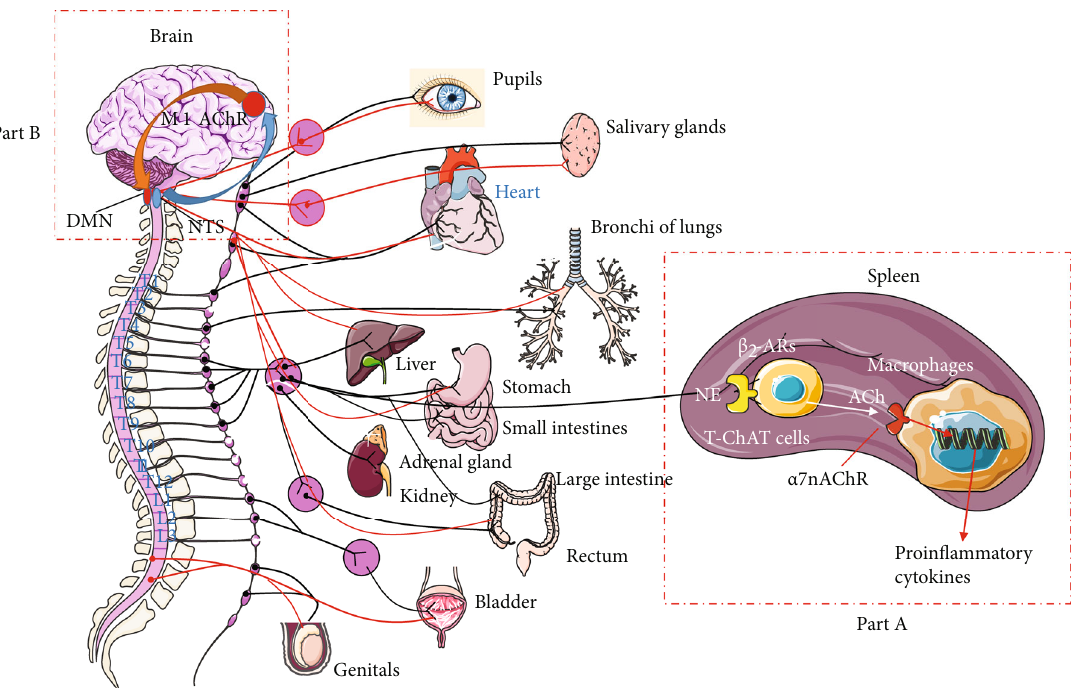
Figure 1: Parasympathetic and sympathetic nervous systems regulate in fl ammation of internal organs. Sympathetic and parasympathetic systems innervate almost all internal organs. Current studies have con fi rmed that the vagus nerve can sense in fl ammatory signals and transmit them to the Nucleus Tractus Solitarius (NTS) of the Medullary Visceral Zone (MVZ). In MVZ, NTS links to the Rostral Ventrolateral Medulla (RVLM) and Vagus Dorsal Motor Nucleus (VDMN) to process the incoming information. On the other hand, MVZ connects the hypothalamus, basal forebrain (BF), and forebrain upwards and connects the locus coeruleus downwards so that the sympathetic and vagus systems, the autonomic nervous system, and the neuroendocrine regulation system can cooperate to regulate in fl ammation and immunity. (a) The regulation of Cholinergic Anti-in fl ammatory Pathways (CAP) on systemic in fl ammation. After the e ff erent vagus fi bers from the Vagus Dorsal Motor Nucleus (VDMN) shift neurons in the upper abdominal cavity mesenteric ganglion complex, their postganglionic fi bers enter the spleen and release norepinephrine which acts on the T lymphocytes to facilitate synthesizing ACh, and the latter activate α 7nAChRs on the monocytes to inhibit releasing proin fl ammatory cytokines. (b) The central regulation pathway of the cholinergic system. After the in fl ammatory information from NTS is modi fi ed by BF, the postganglionic fi bers of BF release ACh which bind to the M1AChRs on the cholinergic neuron of the forebrain to regulate the systemic in fl ammation and immunity through